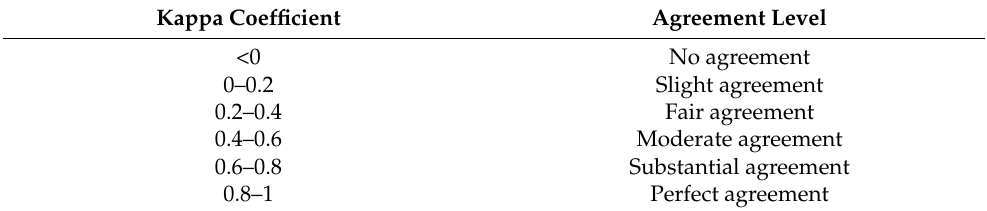
Table 1. Kappa coefficients and the corresponding agreement level [8].